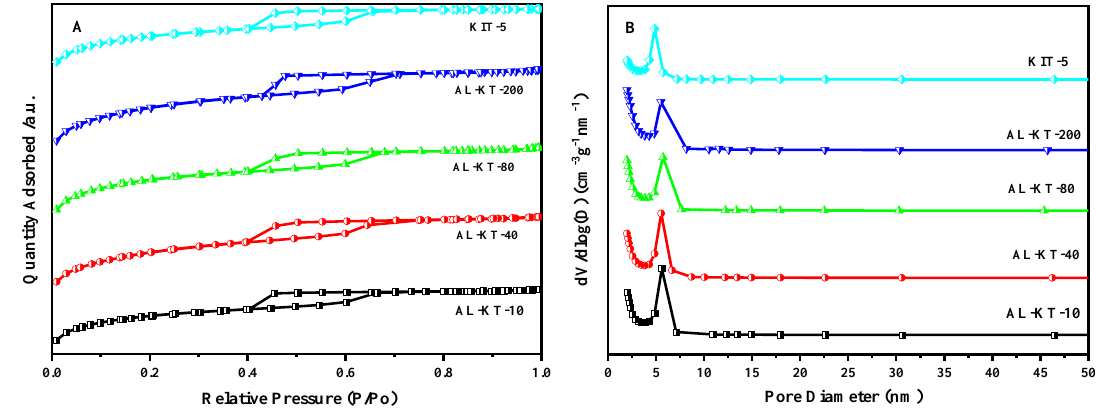
Figure 2. ( A ) The N 2 adsorption-desorption isotherms and ( B ) pore size distributions of the supports.